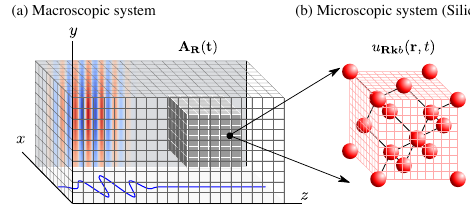
Fig. 1. Schematic illustration of 3D Maxwell + 3D TDDFT multiscale simulation. (a) Macroscopic grid system to solve Maxwell equation. (b) Microscopic grid system to calculate electron